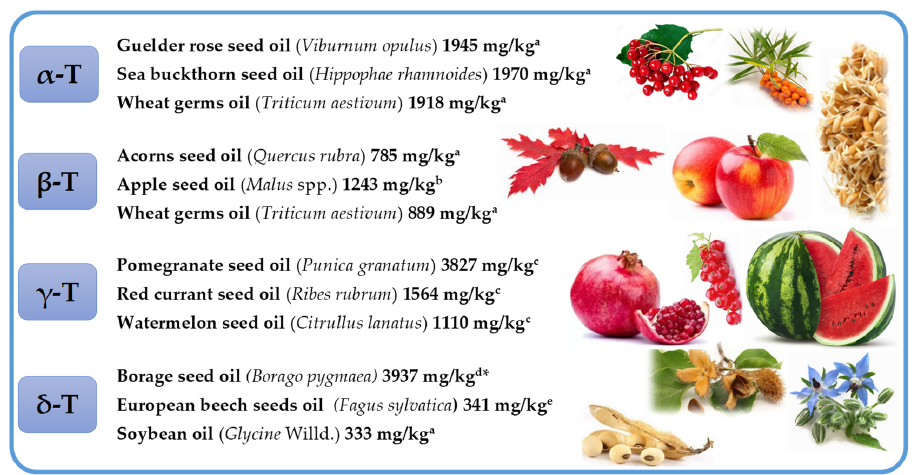
Figure 4. Selected richest sources of four tocopherol (T) homologues (α, β, γ, and δ). * Concentration of tocopherols was calculated as α-tocopheryl acetate equivalents. Superscripts ( a–e ) refers to